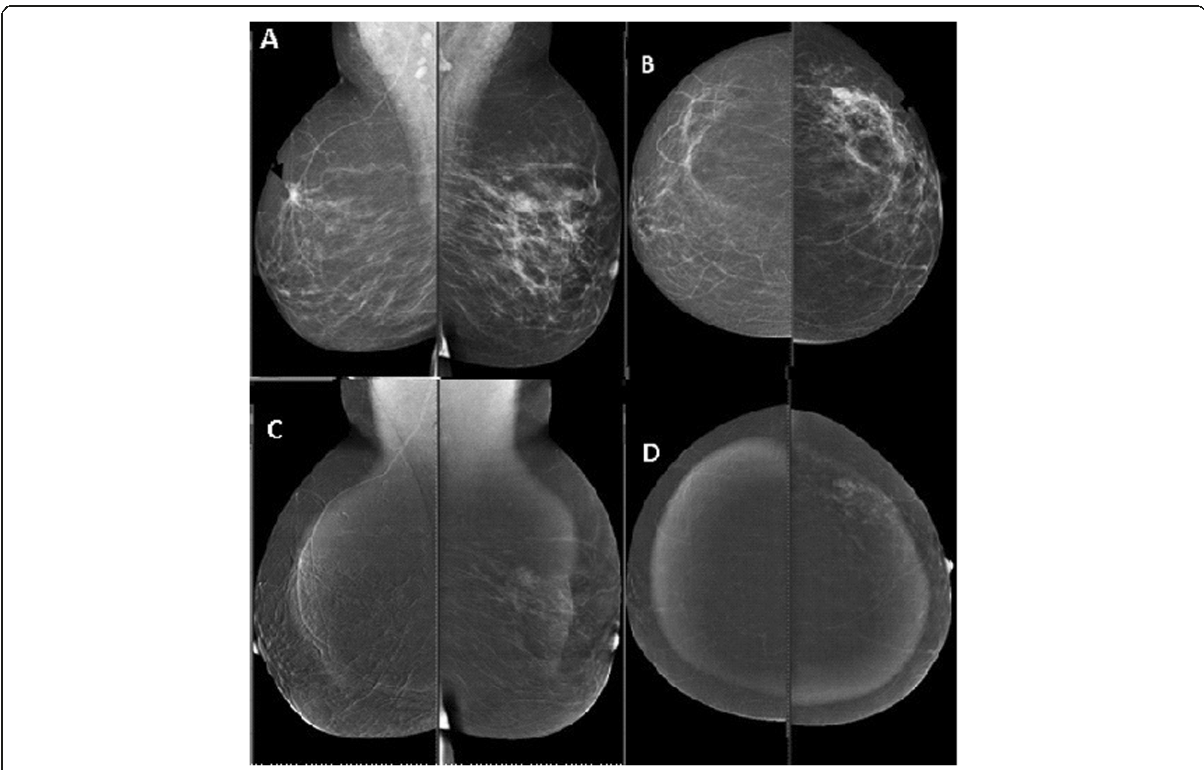
Fig. 1 Right breast focal asymmetry (straight arrow) ( a ). Left breast global asymmetry (curved arrow) ( b ). The right breast asymmetry was an adenotic nodule and did not show contrast uptake ( c ) while the left breast asymmetry was an invasive lobular carcinoma and showed heterogeneous non-mass contrast uptake ( d )